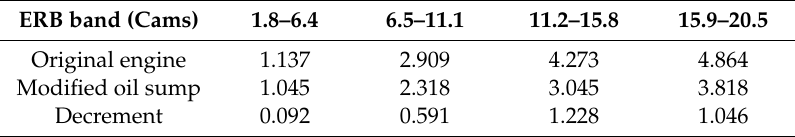
Table 6. Rating scale definitions of subjective annoying feelings.